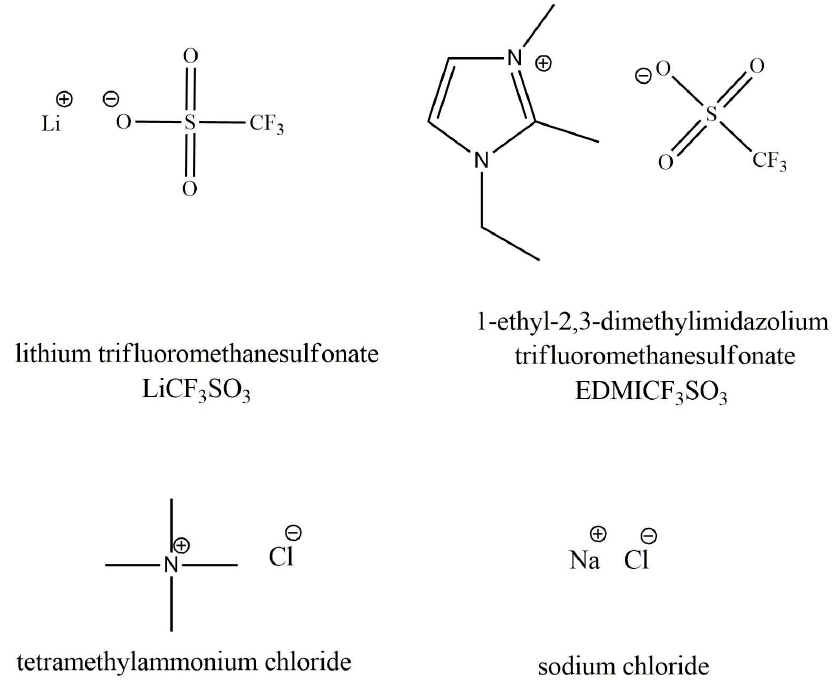
Figure 1. Structures of the ions of the salts considered as the electrolytes.